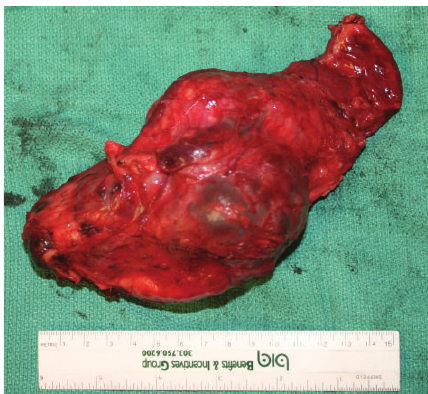
Figure 1: Gross image of the highly vascular and well-circumb- scribed mass excised during sternotomy, measuring 10 × 10 × 13 cm.